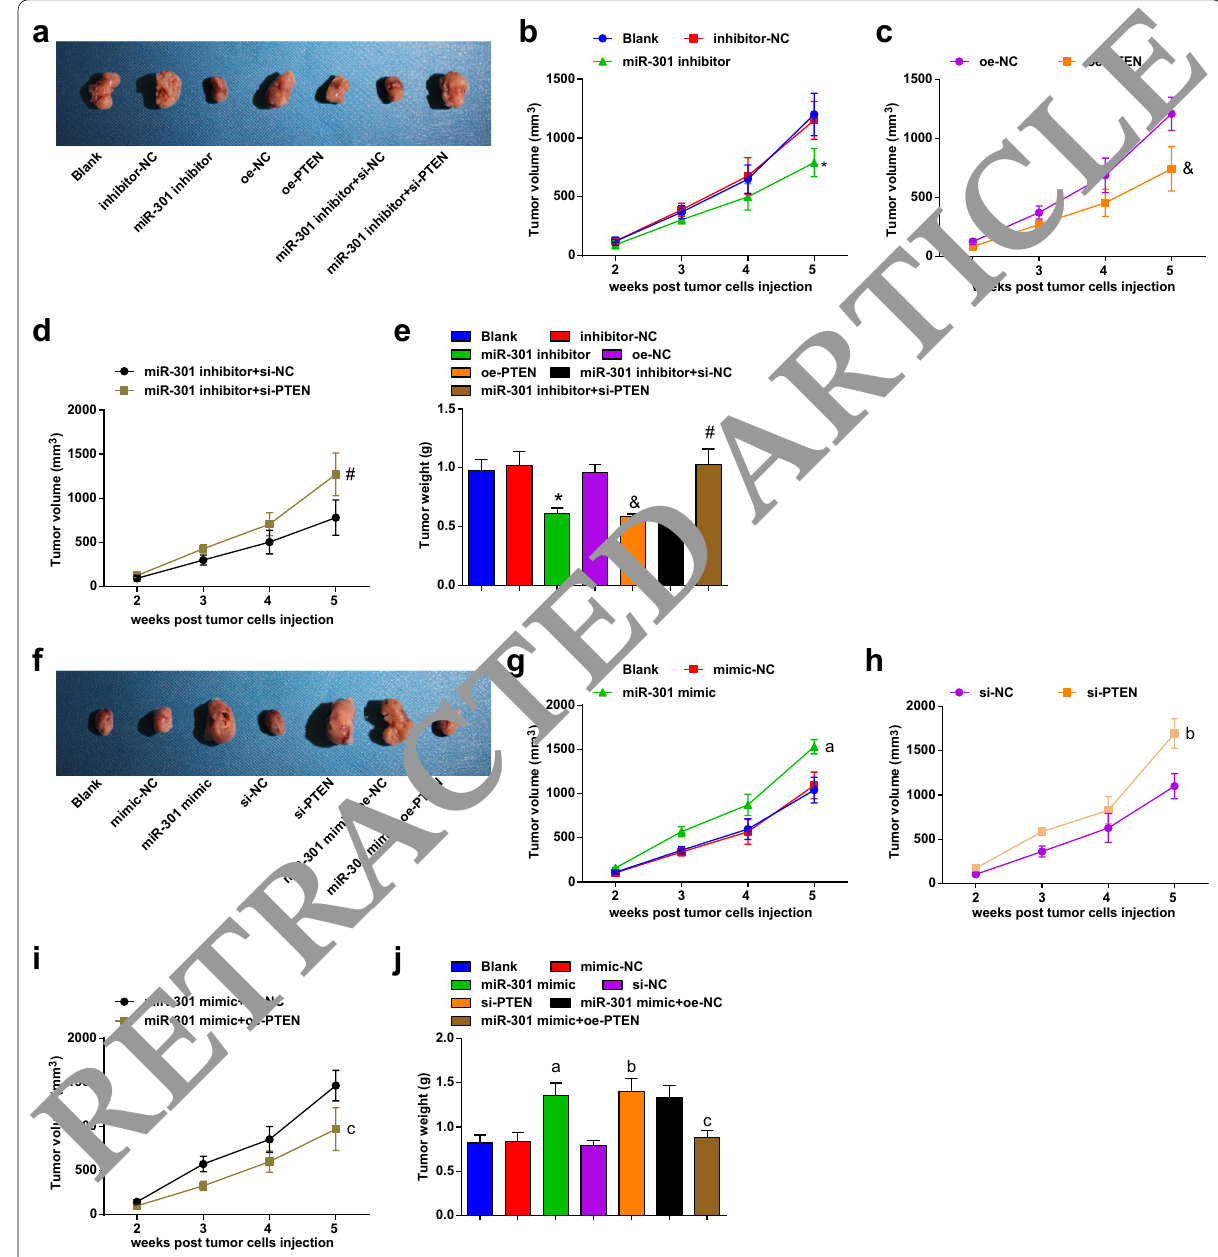
Fig. 6 Inhibited miR-301 or overexpressed PTEN restrains tumor growth in ESCC; elevated miR-301 or reduced PTEN increases tumor growth in ESCC. a Representative figures for the tumor growth observed by subcutaneous tumorigenesis in nude mice after KYSE-30 cells were transfected; b–d changes of tumor volume of each group after KYSE-30 cells were transfected; e changes of tumor weight of each group after KYSE-30 cells were transfected; f representative figures for the tumor growth observed by subcutaneous tumorigenesis in nude mice after Eca109 cells were transfected; g–i changes of tumor volume of each group after Eca109 cells were transfected; j changes of tumor weight of each group after Eca109 cells were transfected. * P < 0.05 versus the inhibitor-NC group; & P < 0.05 versus the oe-NC group; # P < 0.05 versus the miR-301 inhibitors group; a P < 0.05 versus the mimic-NC group; b P < 0.05 versus the si-NC group; c P < 0.05 versus the miR-301 mimic were expressed as mean standard deviation, and ANOVA was used for comparisons among multiple ±